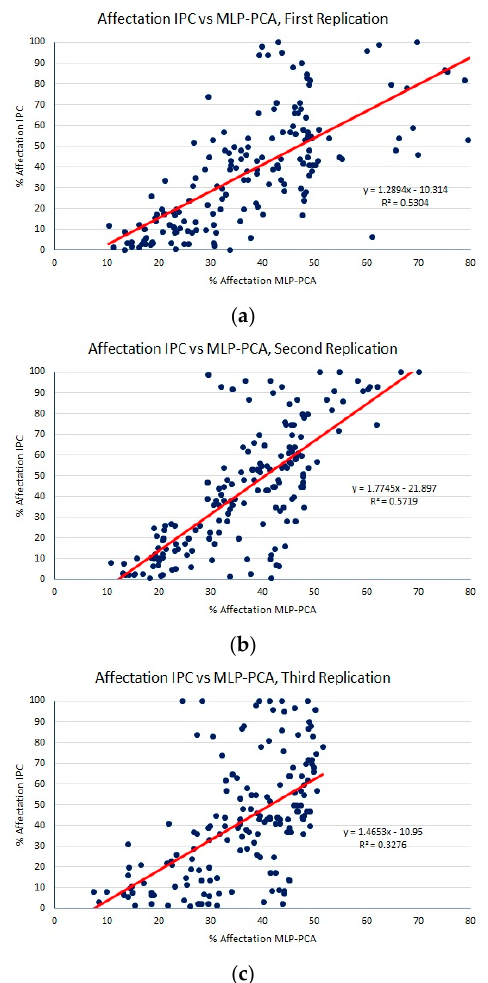
Figure 8. Percentage of P. infestans affectation using IPC methodology vs. estimated percentage of affectation using MLP on the PCA dataset, for ( a ) first replication, MAE: 15.06, RMSE: 19.31, R 2 : 0.5304; ( b ) second replication, MAE: 16.95, RMSE: 22.03, R 2 : 0.5719; ( c ) third replication, MAE: 17.80, RMSE: 24.28, R 2 : 0.3276. PCA: principal components